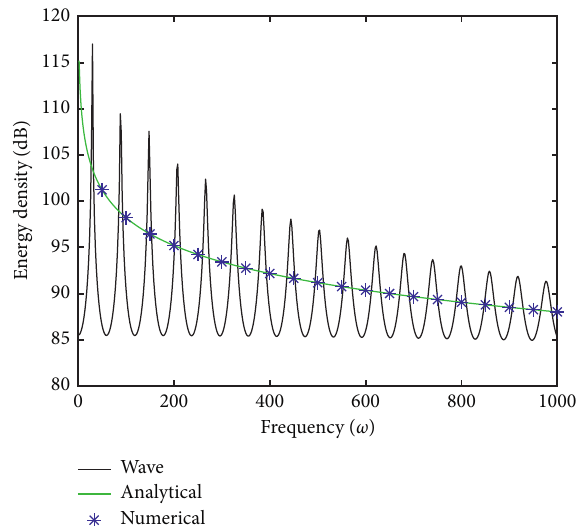
Figure 10: Energy densities of the beam in the frequency field. The reference energy density is 10 − 12 J/m 2